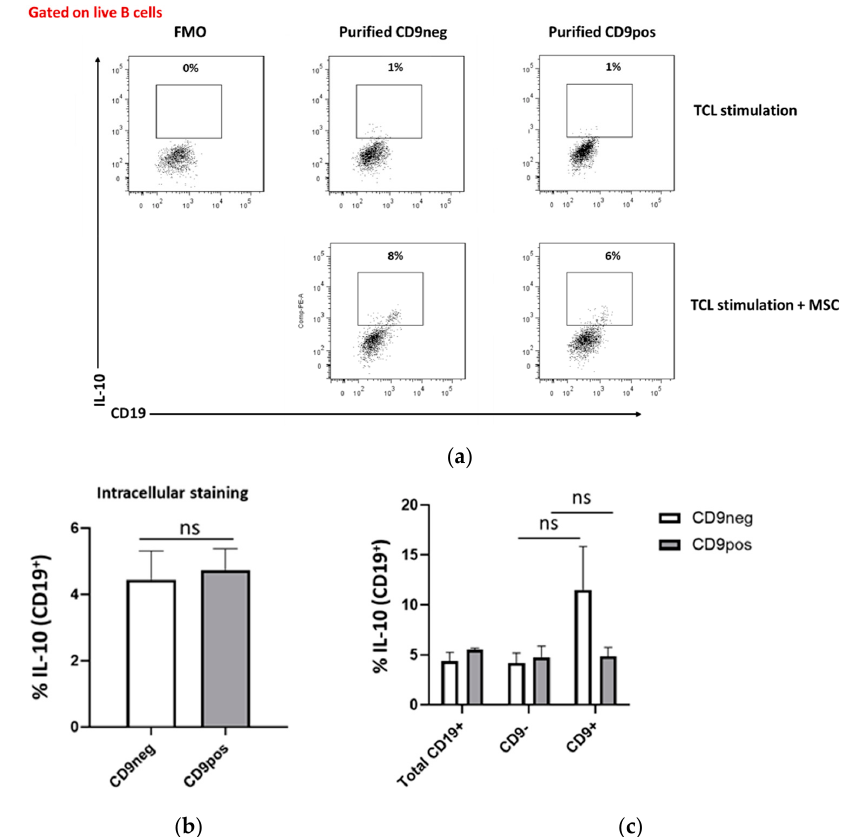
Figure 5. IL-10 expression can be induced in both purified CD9 negative- and positive-B cells. Tonsil cells were sorted into purified CD9neg and CD9pos B cells then cultured under the transitional cell-inducing condition with T cell-like stimulation + MSC. At day 7, the cells were re-stimulated with PMA/ionomycin/monensin and intracellular expression of IL-10 was analyzed. ( a ) Representative flow cytometry plots of IL-10 induction by MSC. ( b ) No significant differences in comparing IL-10 expression in the purified CD9neg and CD9pos B cell populations. ( c ) Purified CD9neg and CD9pos B cells were stained for CD9 at day 7 of incubation and IL-10 expression was analyzed within CD19 + CD9 − and CD19 + CD9 + gating. No significant differences in IL-10 compartmentalization within CD9 − and CD9 + of the purified cells. Data show at least three independent experiments in each group; ns (non-significant) p > 0.05. Unpaired t -test was performed to determine statistical significance. FMO, Fluorescence Minus One